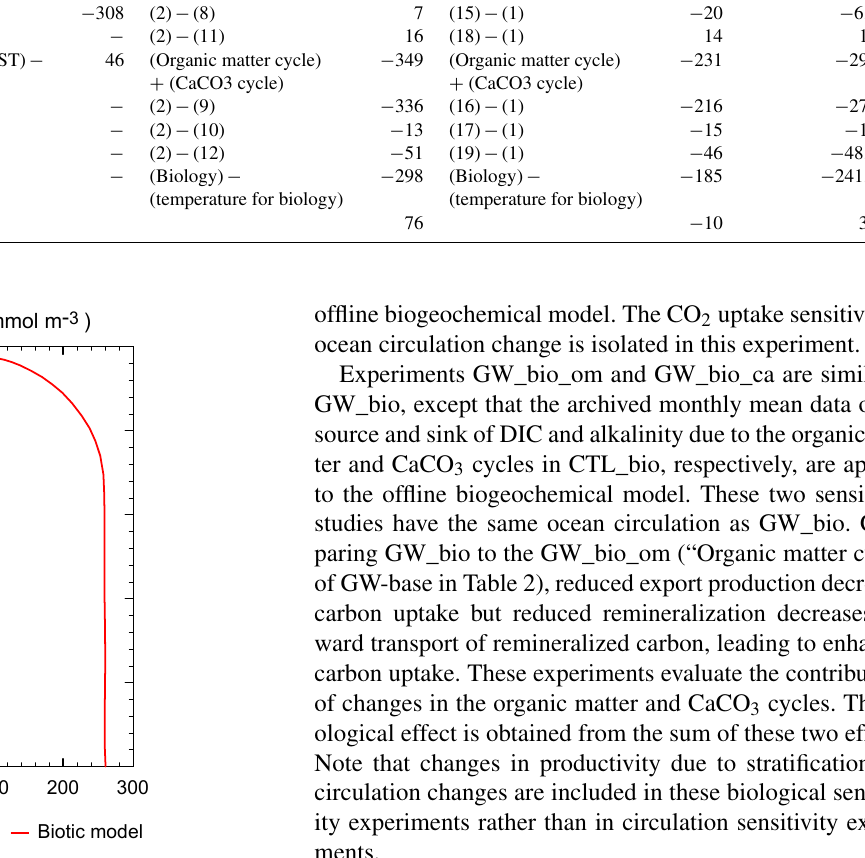
Figure 1. Vertical profile of the anomaly of salinity-normalized DIC from the surface under the preindustrial condition. The black and red lines show the abiotic and biotic models,